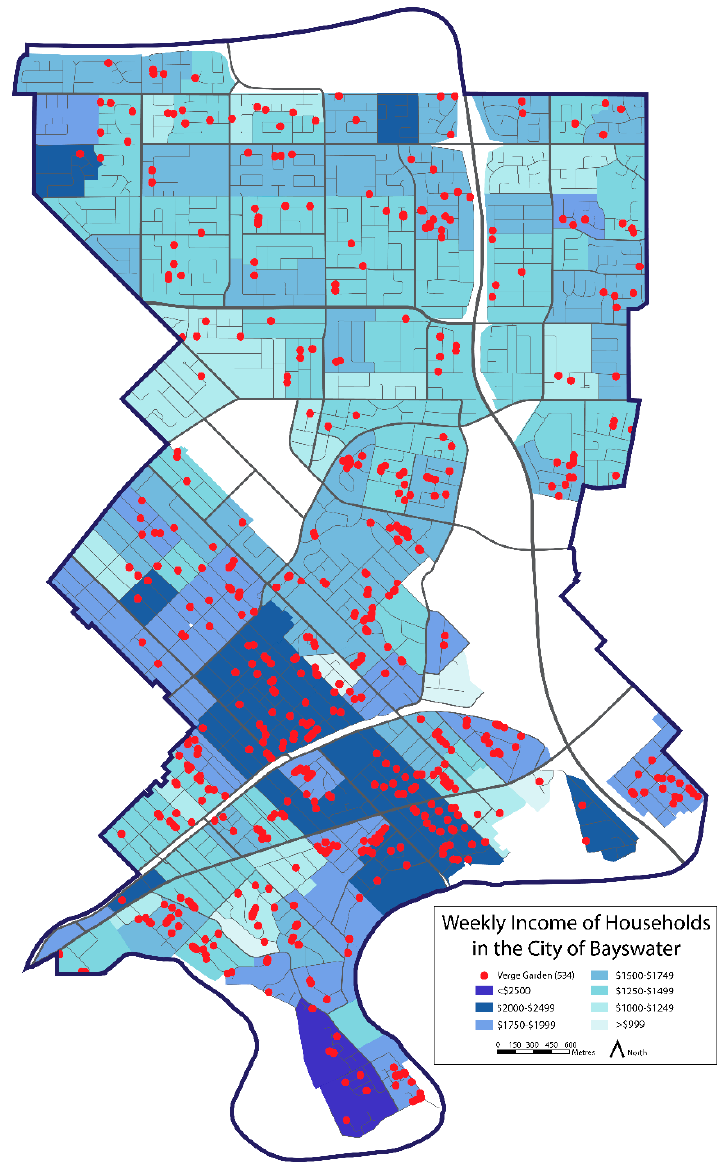
Figure 7. The weekly income of households and the presence of verge gardens.